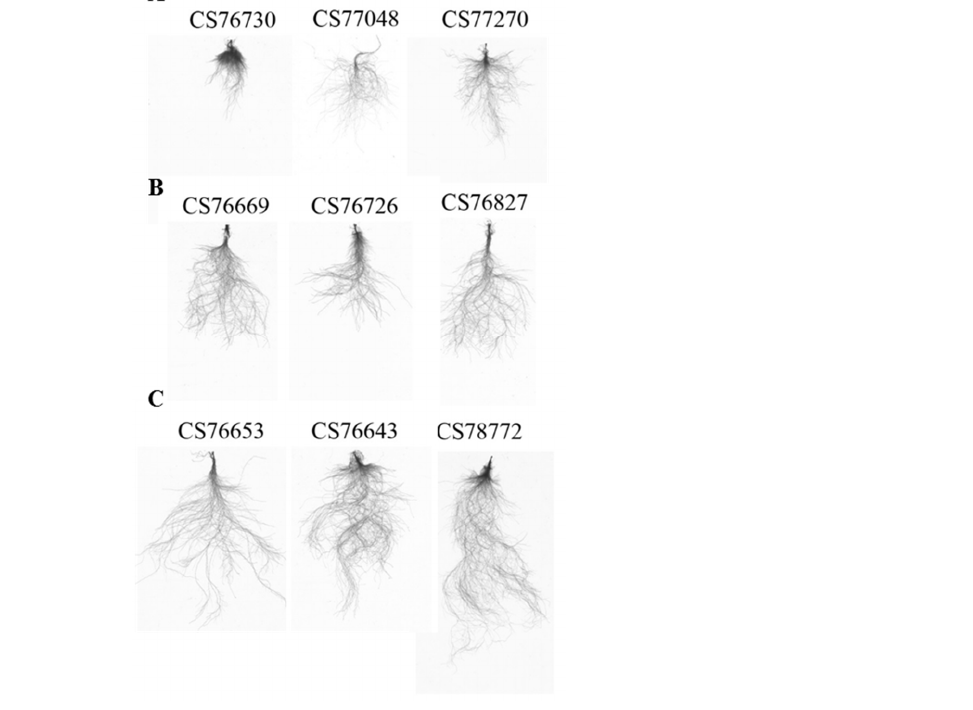
Figure 2. Natural variation of root growth pattern observed in Arabidopsis ecotypes. The WinRHIZO root scan images of randomly selected ecotypes with high phenotypic variation are presented. Representative images of ( A ) acid mine drainage (AMD)-sensitive, ( B ) moderately AMD-sensitive, and ( C ) AMD-tolerant Arabidopsis accessions are shown.